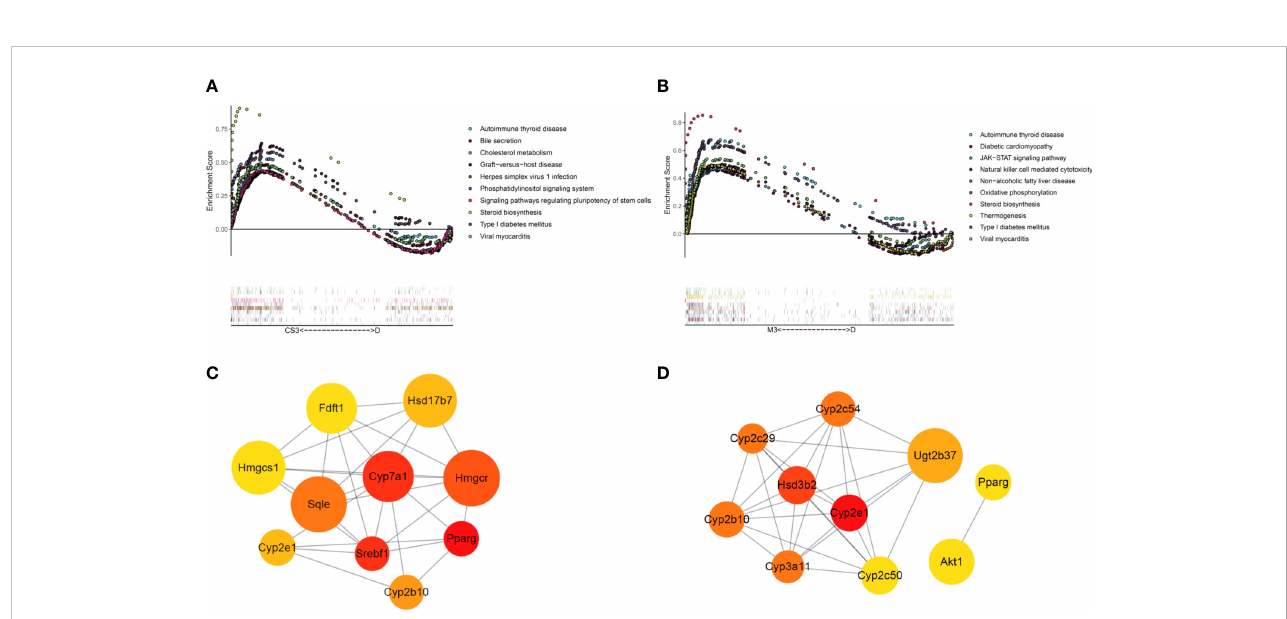
FIGURE 8 GSEA and PPI network of DEGs in the CS271011 3 mg/kg group and MGL-3196 3 mg/kg group. (A) GSEA of DEGs (CS3 vs. D); (B) GSEA of DEGs (M3 vs. D); (C) Nodes of the PPI network of screened DEGs and hub genes (CS3 vs. D); (D) Nodes of the PPI network of screened DEGs and the top ten hub genes (M3 vs. D). Nodes represent different proteins, the color of the nodes ranges from red to yellow, is related to the degree of interaction, and the size of a node is positively correlated with the log2FoldChange value. D, DIO control group; CS3, CS271011 3 mg/kg group; M3, MGL-3196 3 mg/kg group; GSEA, Gene Set Enrichment Analysis; PPI, protein − protein